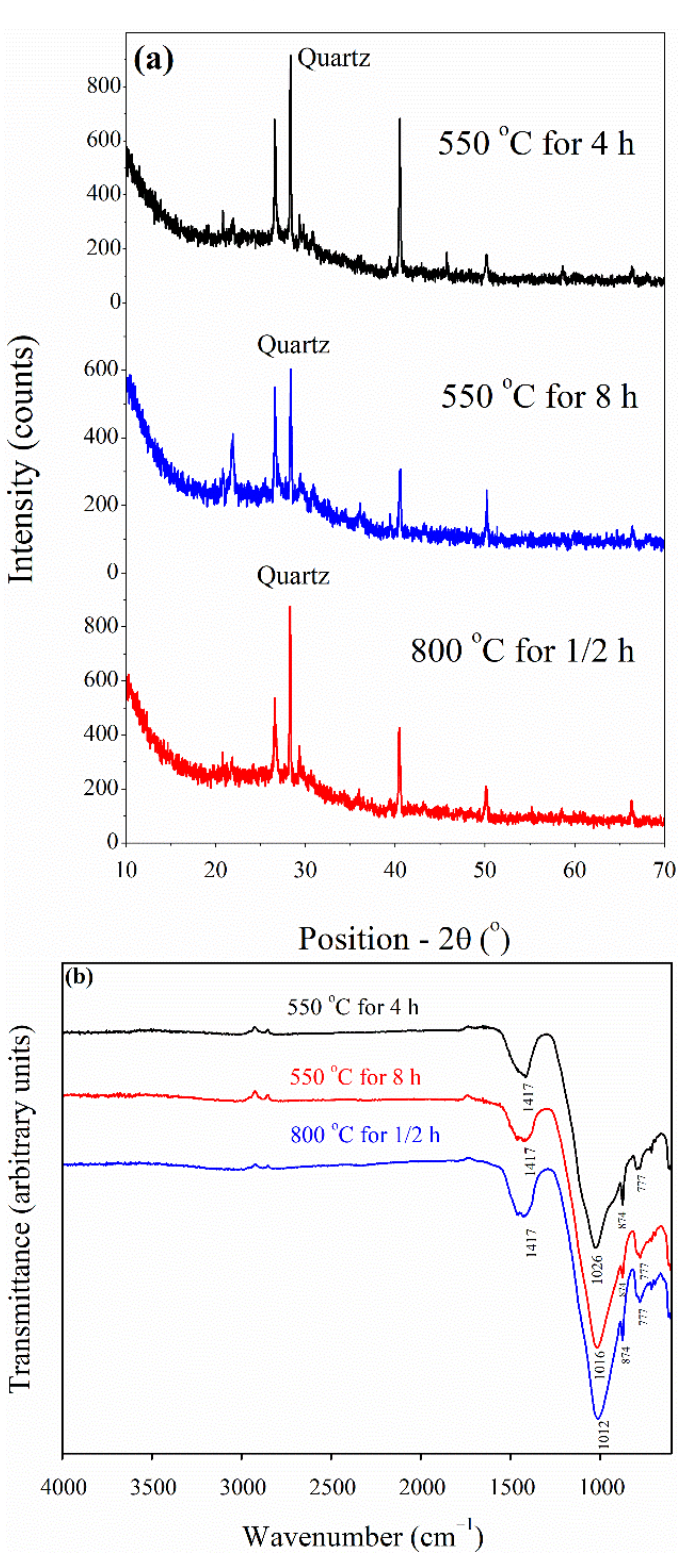
Figure 1. ( a ) XRD pattern and ( b ) FTIR of WSA after heat treatment at 550 °C for 4 and 8 h, and at 800 °C for 30